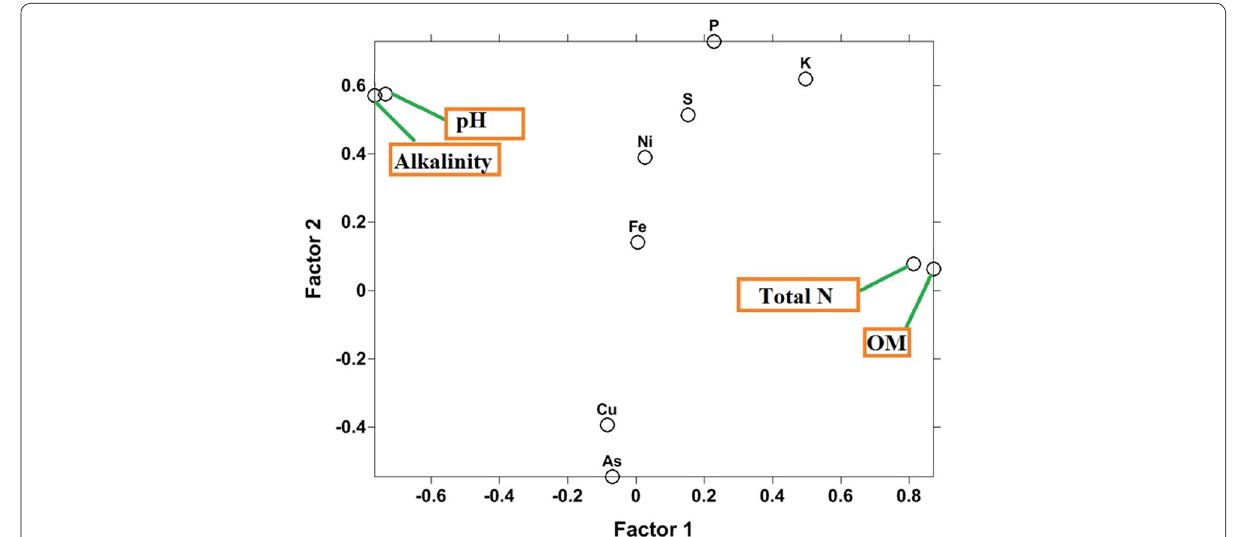
Fig. 4 The bi-plot analysis for factor 1 & factor